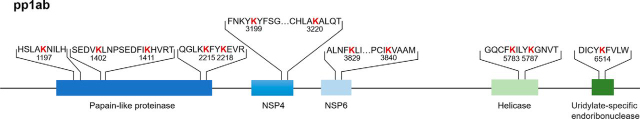
Distribution of acetylation sites on ORFs of pp1ab.